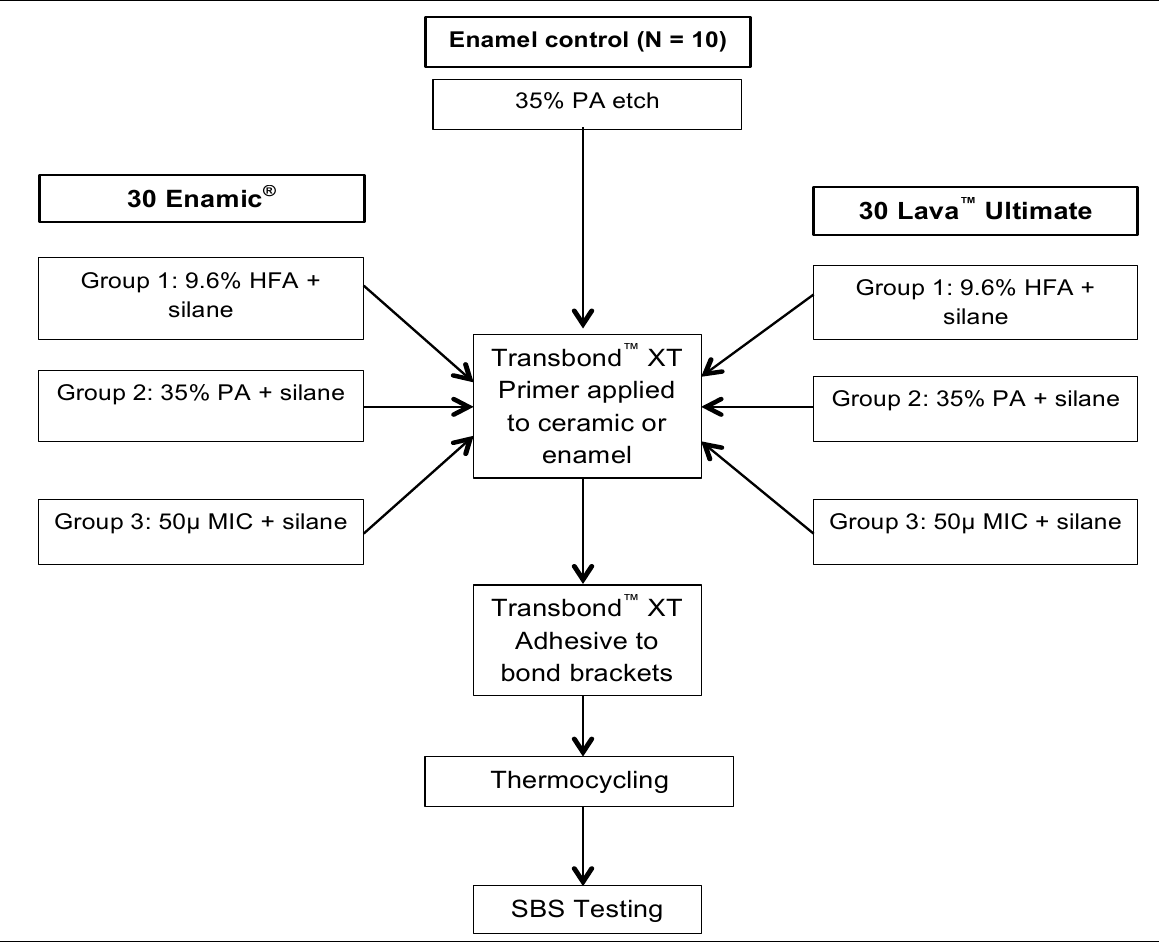
Figure 1. Flow-chart of the sample preparation process used in this